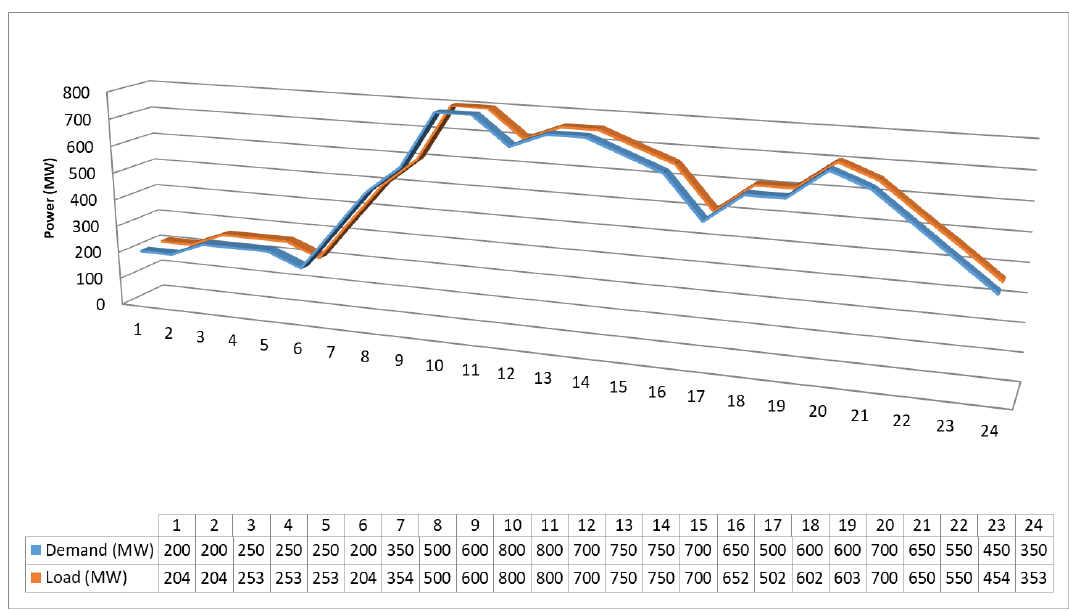
Figure 5. PEVs Load leveling. Note: The PEVs is considered as load during off peak excluding hour 8, until hour 15, and hour 20 until hour 22.